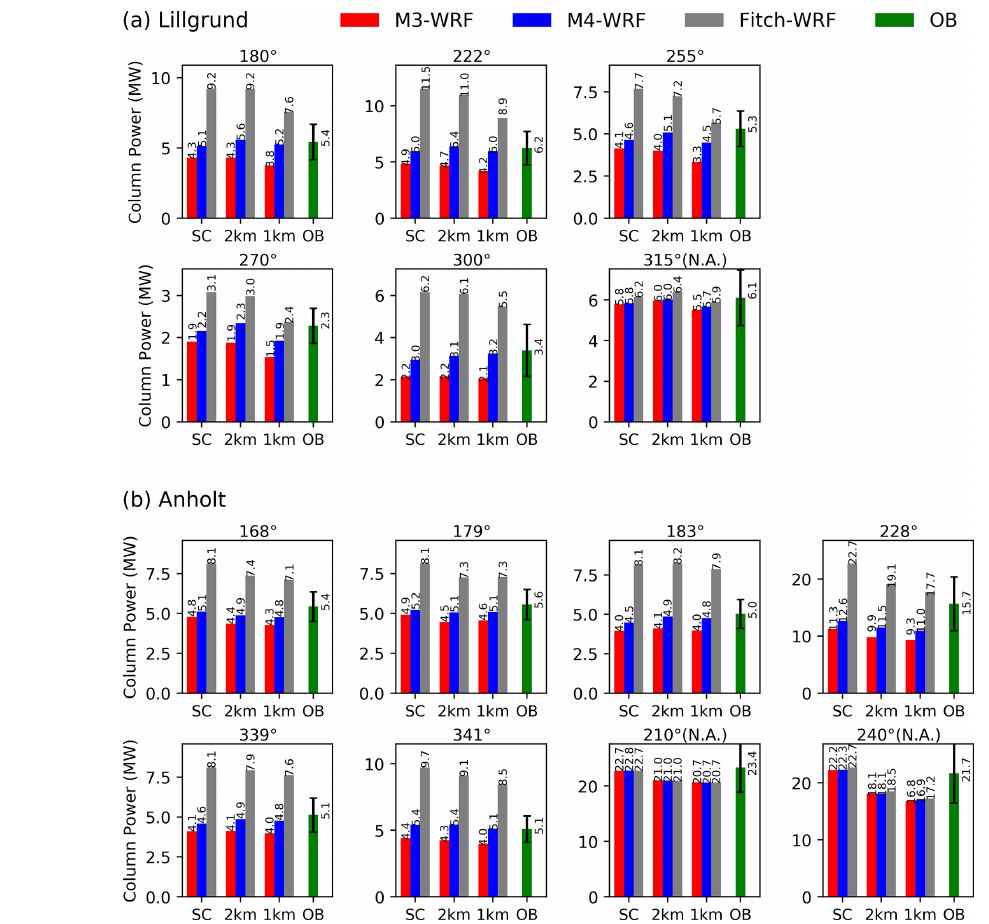
Figure 11. Same as Fig. 10 but for selected directions at Lillgrund and Anholt for which observations were